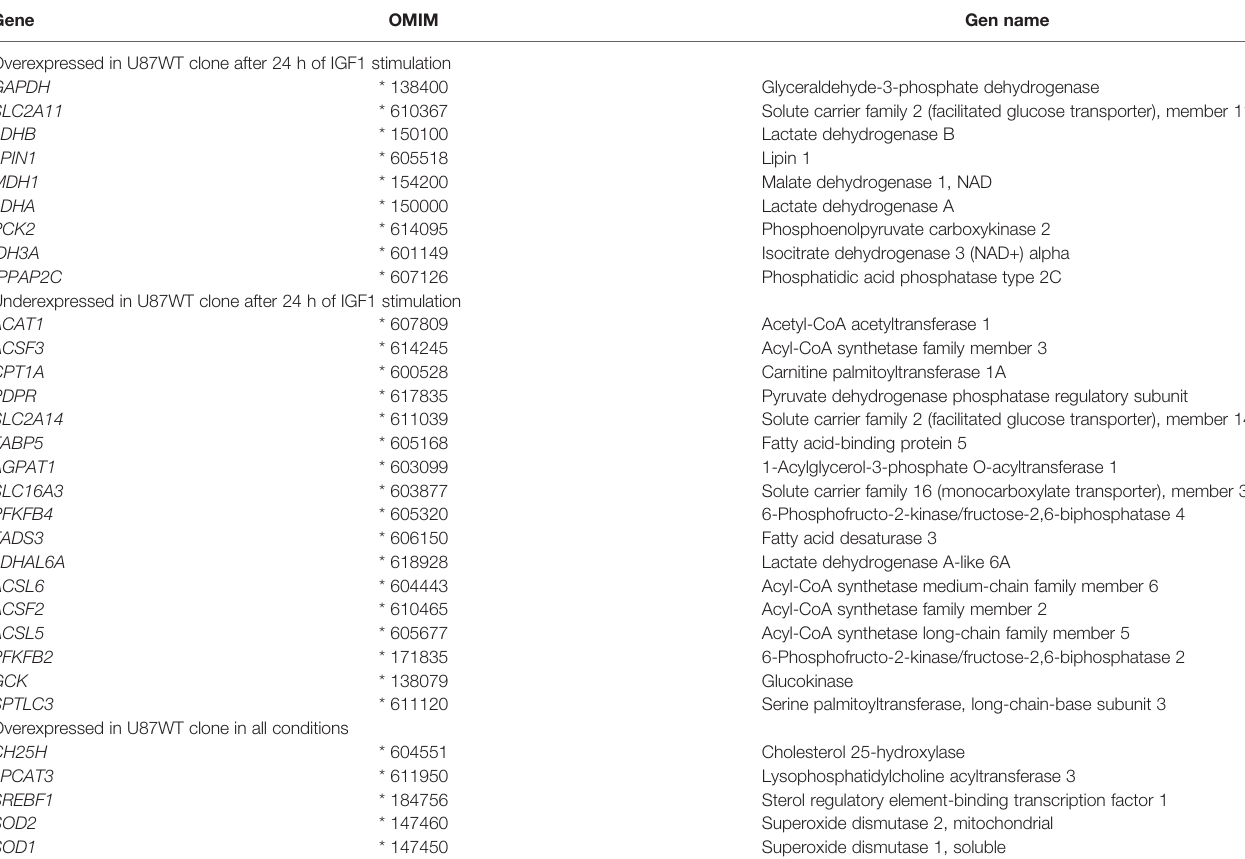
TABLE 1 | Genes related to metabolism over- or underexpressed in U87WT vs . U87Mut cells. Gene OMIM Gen name Overexpressed in U87WT clone after 24 h of IGF1 stimulation